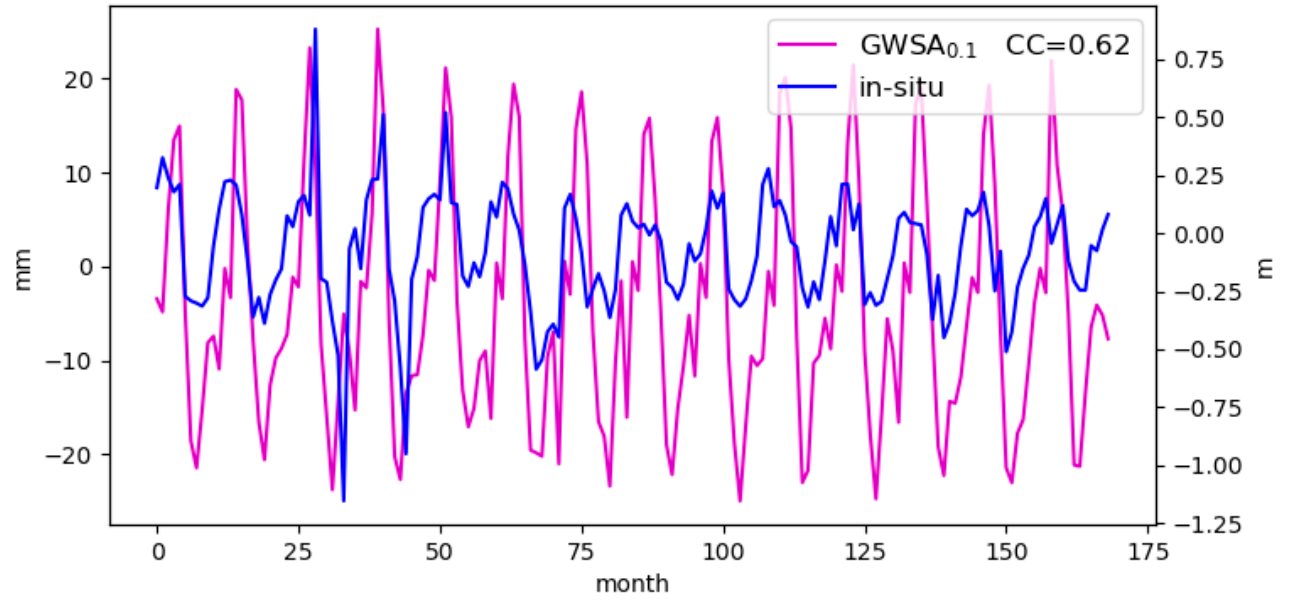
Figure 7. Plain area average changes in GWSA and in situ observations over Qazvin Plain. Monthly GWLA variation (right y -axis with unit m in EW).